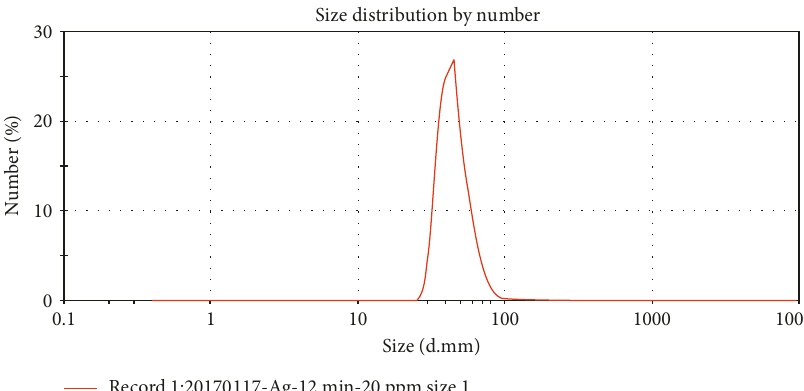
Figure 15: Particle size distribution of aqueous colloid silver (arcing in DW + PVA for 12